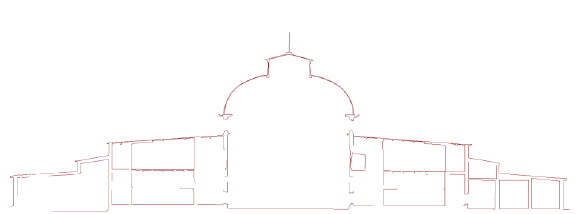
Figure 9. Vertical section passing through the center of the dome extracted from the